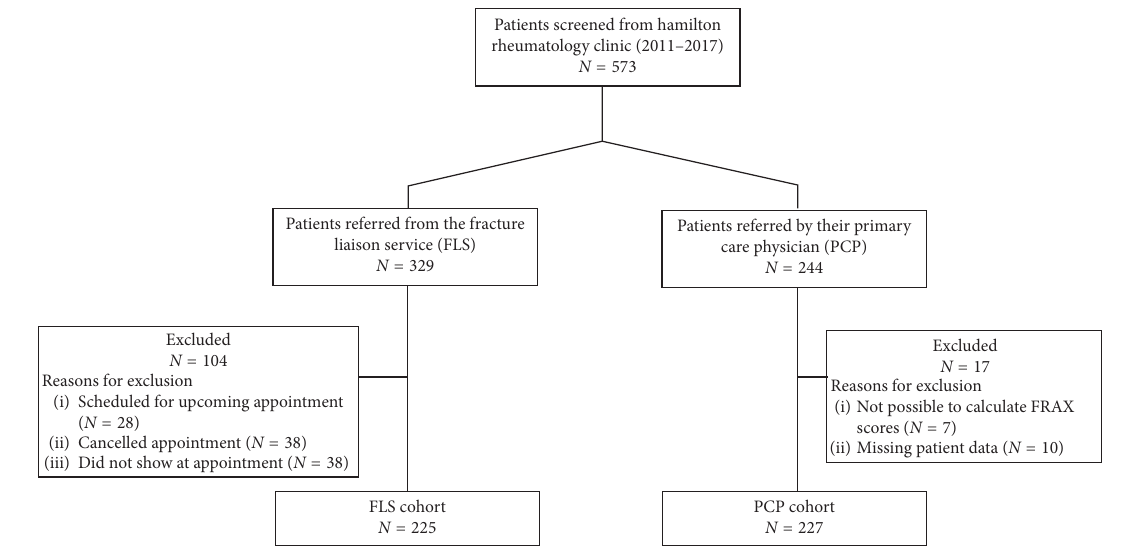
Figure 1: Enrollment of patients. Table 1: Participant characteristics.